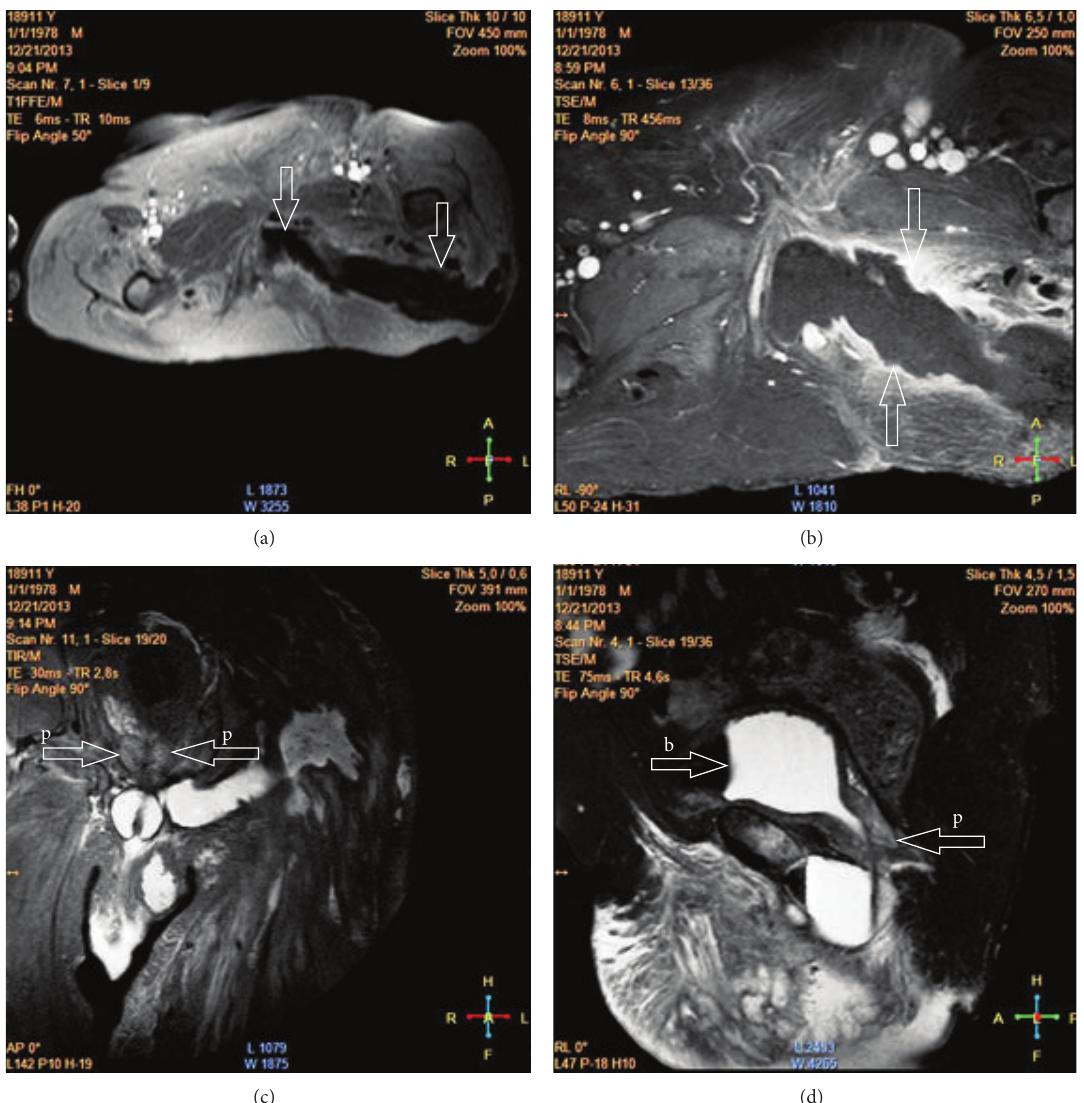
Figure 1: ((a) + (b)) Fluid collection with dense peripheral contrast uptake in sections with contrast extending from deep pelvic muscle groups to the perineum and left gluteal region. ((c) + (d)) p: prostate, b: bladder. This collection extends to perineum, left scrotum, and left gluteal region and is connected to the skin from the gluteal